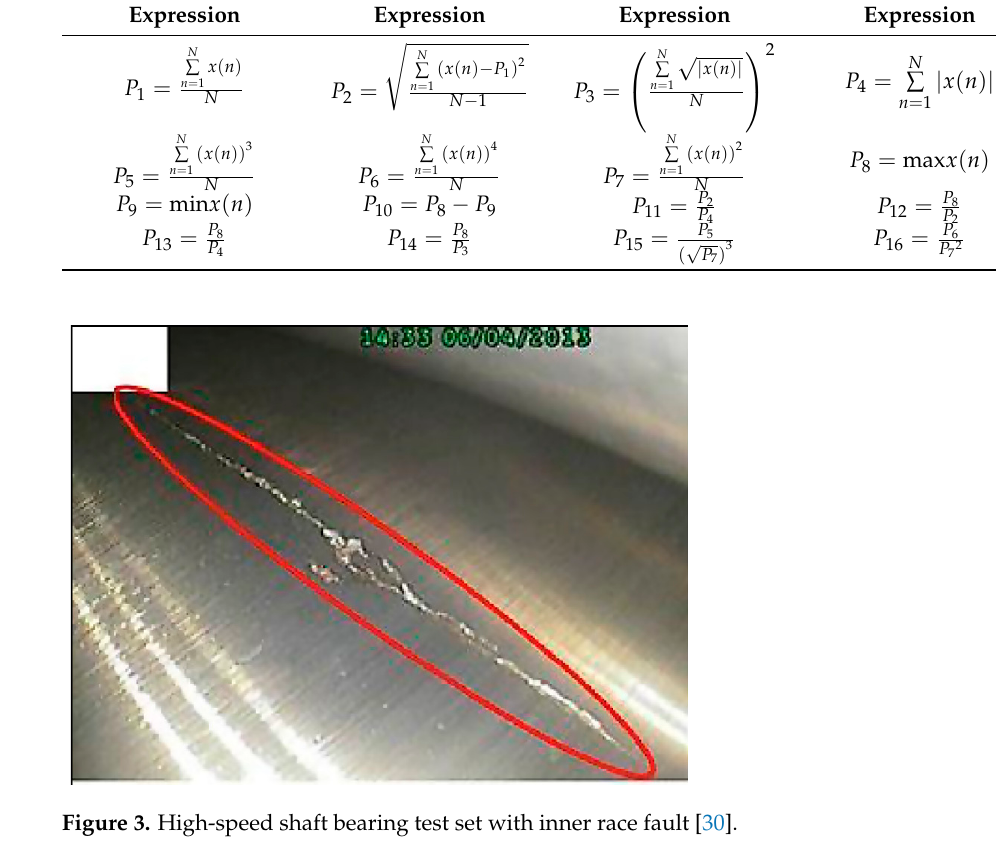
Figure 3. High-speed shaft bearing test set with inner race fault [30].